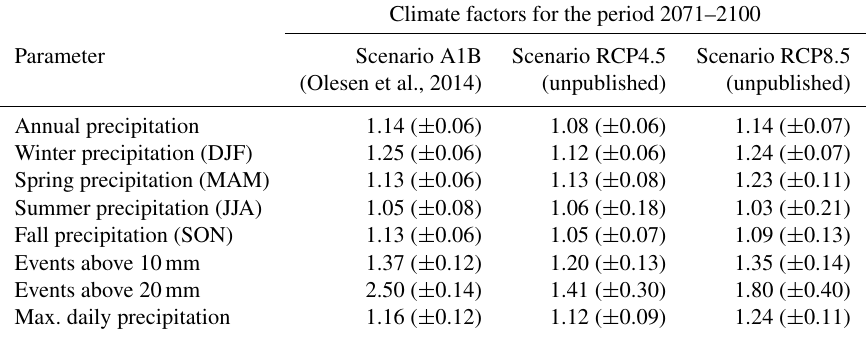
Table 1. The calculated Danish climate changes in annual and seasonal precipitation as well as extremes. The values are expressed as a multiplicative climate factor describing the difference between the reference period 1961–1990 and 2071–2100. The A1B scenario is presented in Olesen et al. (2014) and represents 14 regional climate model runs from the ENSEMBLES project. The climate factors from the two RCP scenarios are previously unpublished, but derived from the Euro-CORDEX-11 database (Jacob et al., 2014) and processed statistically for this paper. Standard deviation is listed in parentheses. The indices marked with bold are the ones used in this